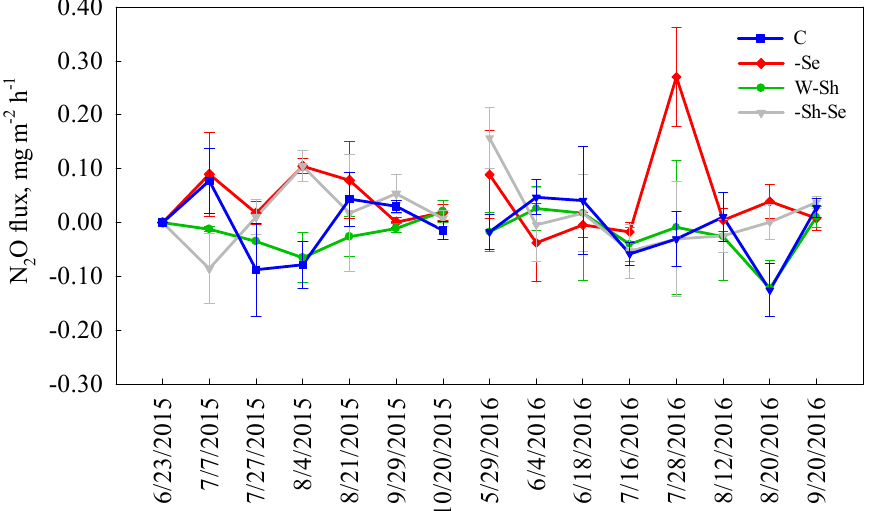
Figure 3. The seasonal variation of N 2 O flux for selected treatments (C, -Se, W-Sh, and -Sh-Se) during the growing seasons of 2015–2016. Error bar represents standard error ( n = 4).